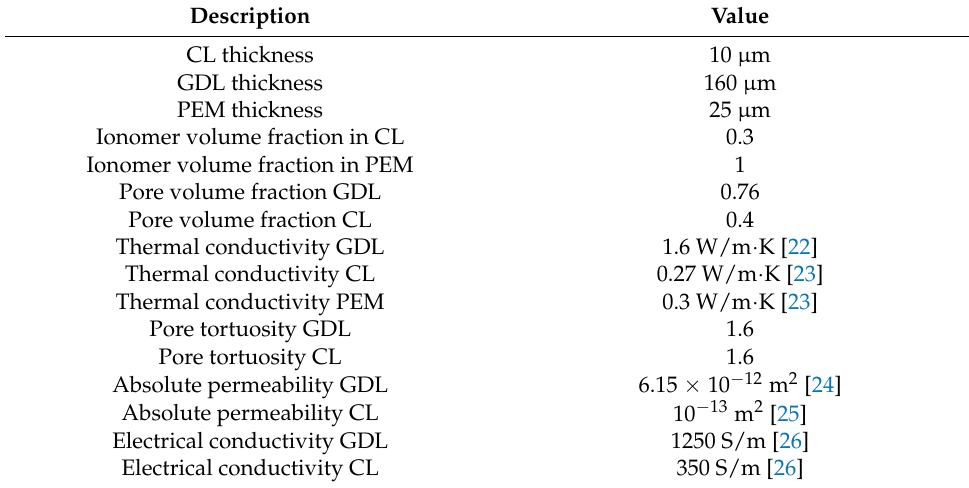
Table 4. Cell dimensions and operating conditions.